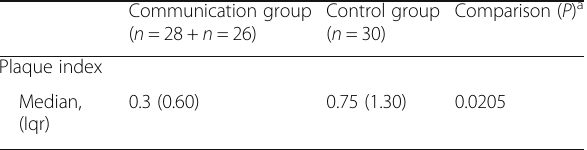
Table 3 Plaque index (PI) change recorded at the first orthodontic checkup 1 month after professional cleaning and